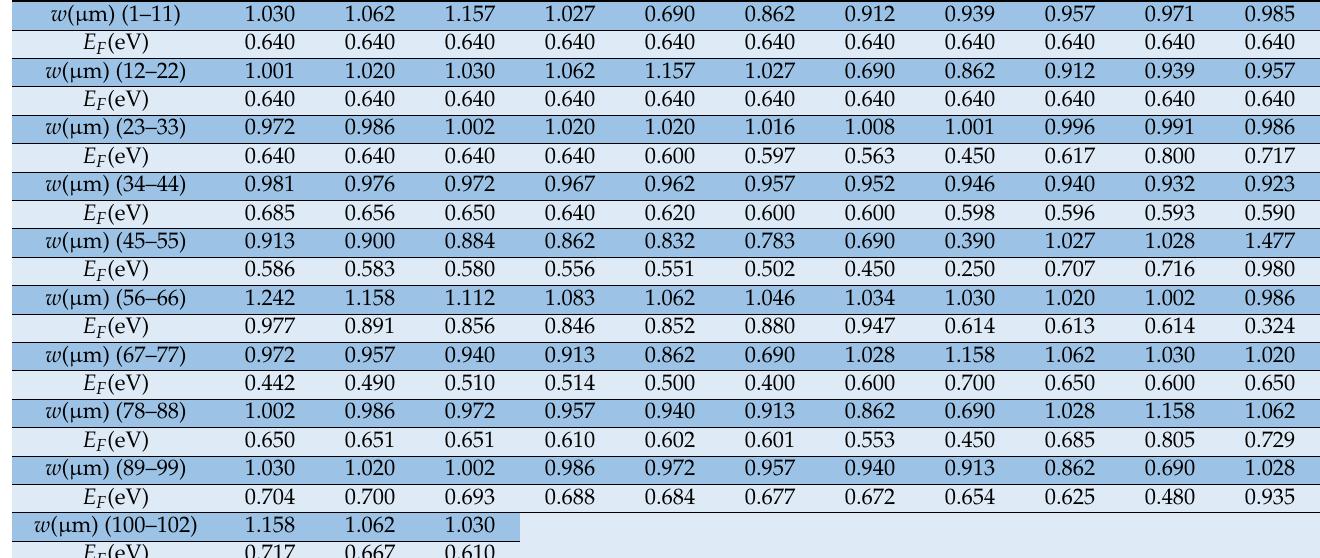
Table 1. The variation of the Fermi energy level for the asymmetric anomalous